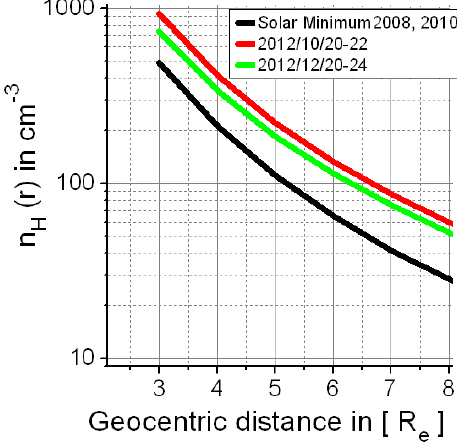
Figure 11. Averaged H-density profiles (power law N(r) ) for solar minimum 2008 and 2010 (black), 20–22 October 2012 (red), and 20–24 December 2012 (green).